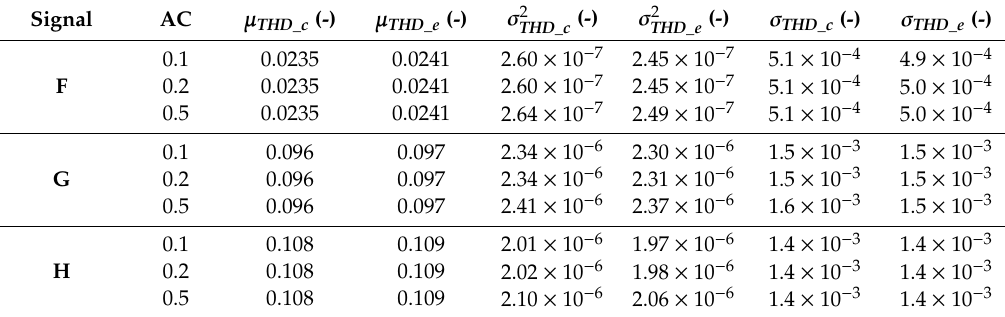
Table 5. Results of the test vs. harmonic accuracy class limit at 5%.